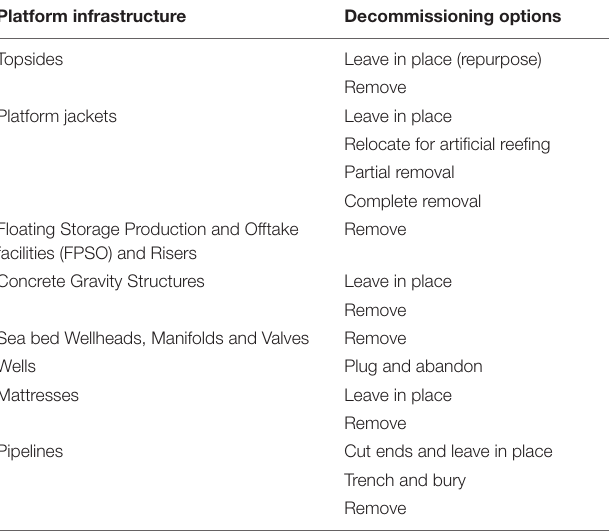
TABLE 1 | Decommissioning options for oil and gas